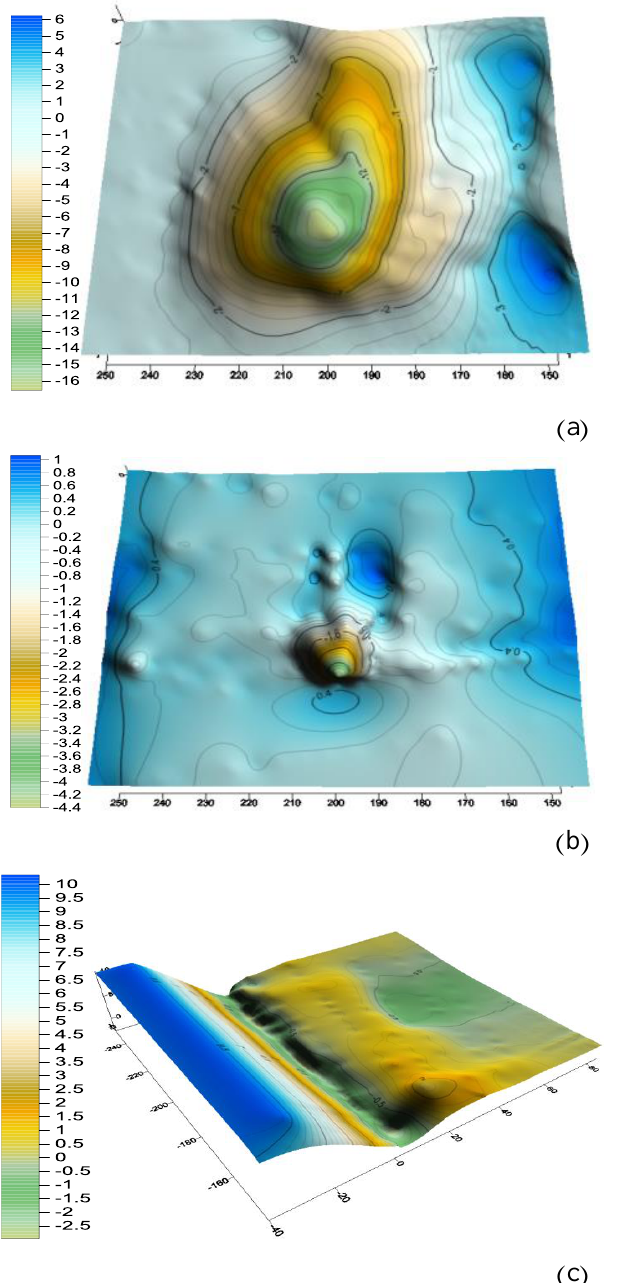
Figure 8. Scour holes created a) around the bridge pier in the case of no base-level drop, b) around the bridge pier in the case of base-level drop, and c) at the beginning of the bend in the case of base- level